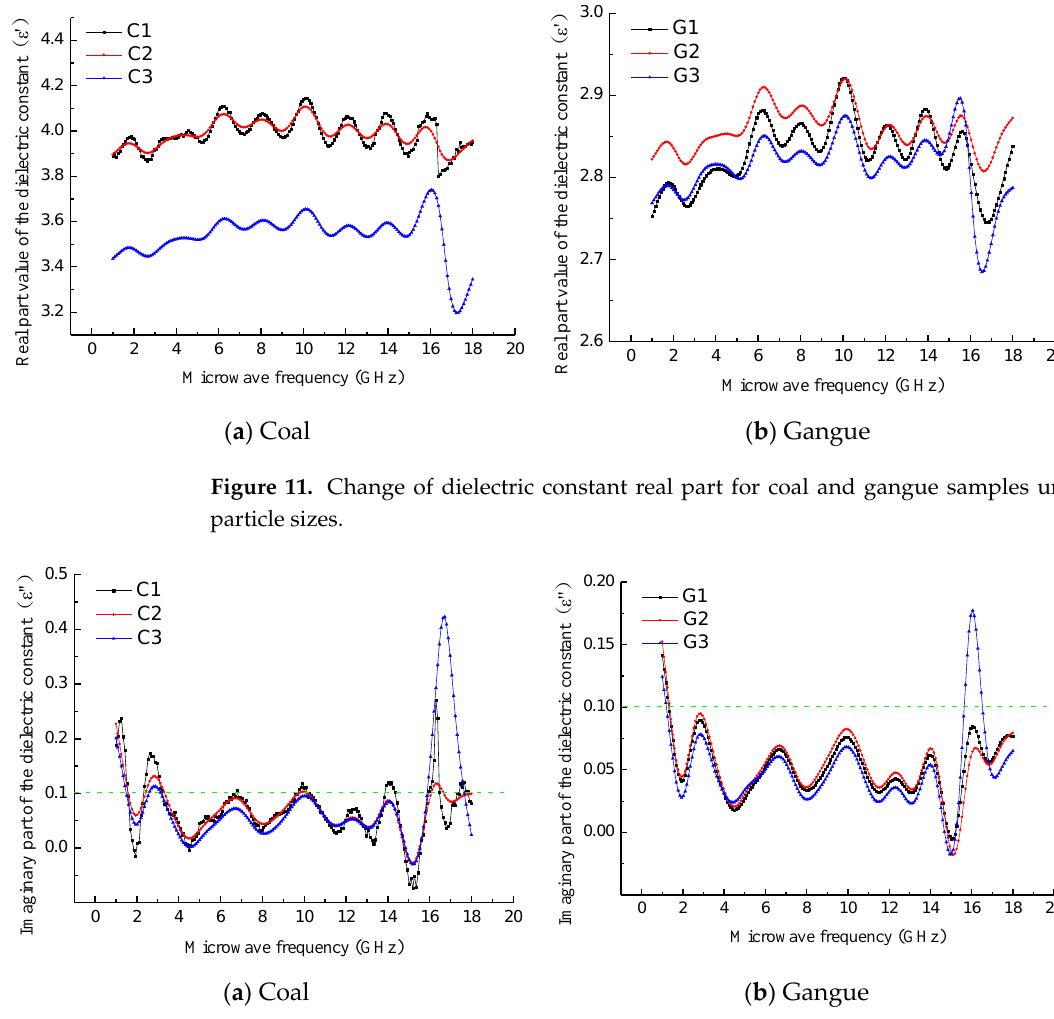
Figure 11. Change of dielectric constant real part for coal and gangue samples under different par- ticle sizes.